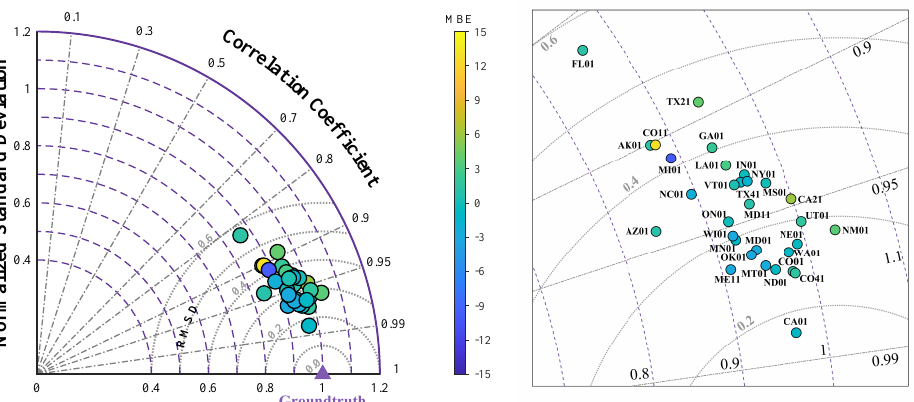
Figure 12. Taylor diagrams for evaluating DRFCN+RF on UVMRP dataset. The point labeled groundtruth represents the reference value. The color of each circle represents the nMBE ( % )